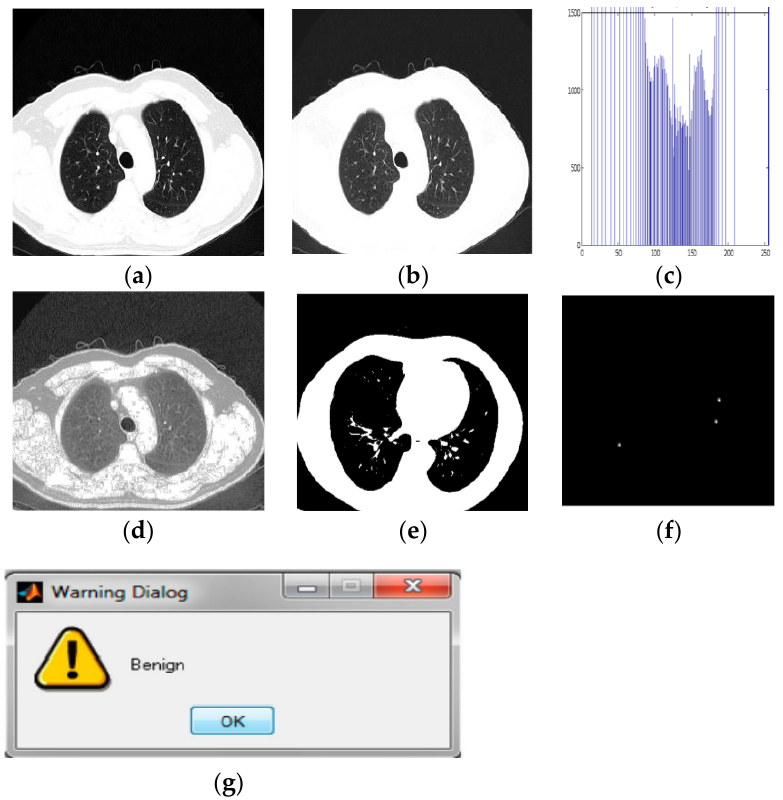
Figure 9. Detection of Benign Sample. ( a ) Input CT Image, ( b ) Pre-processed output, ( c ) Histogram Equalised Image Plot, ( d ) Histogram Equalised Image, ( e , f ) Segmentation image, ( g ) Classification result.